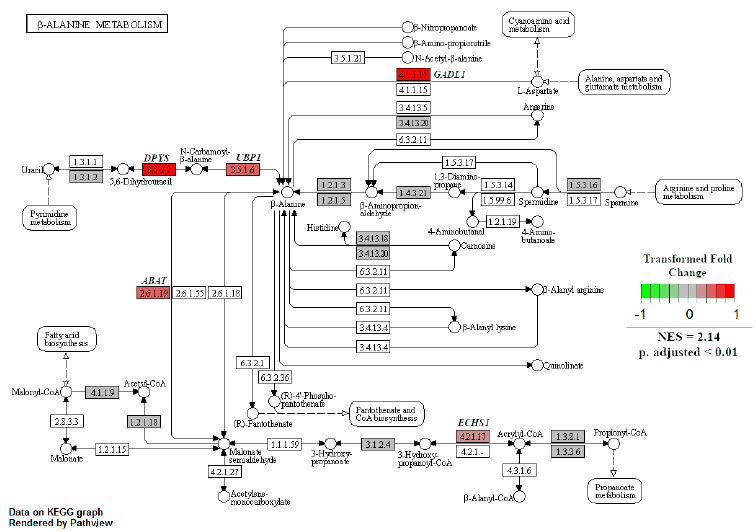
Figure 8. β -Alanine metabolism in NR SGA versus NR NonSGA placentomes at day 70 of pregnancy. Gene set enrichment analysis was performed to identify KEGG pathways that were significantly enriched at adjusted p -values <